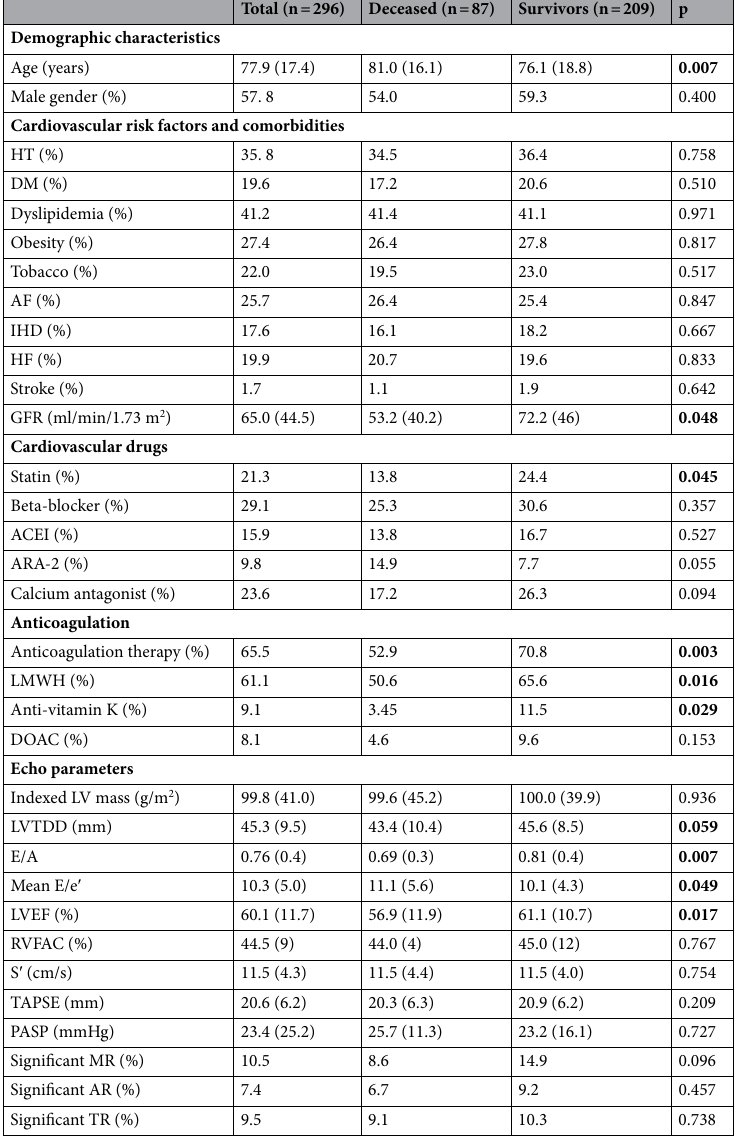
number and percentage. Bold values denote statistical significance at the p < 0.05 level. ACEI angiotensin- converting enzyme inhibitor, AF atrial fibrillation, AR aortic regurgitation, ARA-2 aldosterone receptor 2 antagonist, CKD chronic kidney disease, CVD cerebrovascular disease, DM type 2 diabetes mellitus, DOAC direct-acting oral anticoagulant, FAC fractional area change, HF heart failure, HT hypertension, IHD